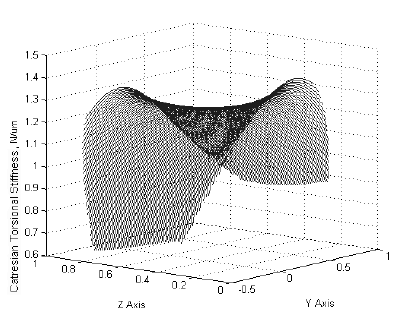
Figure 18: The Cartesian stiffness in the Z-direction as function of the Y- and Z-coordinates.